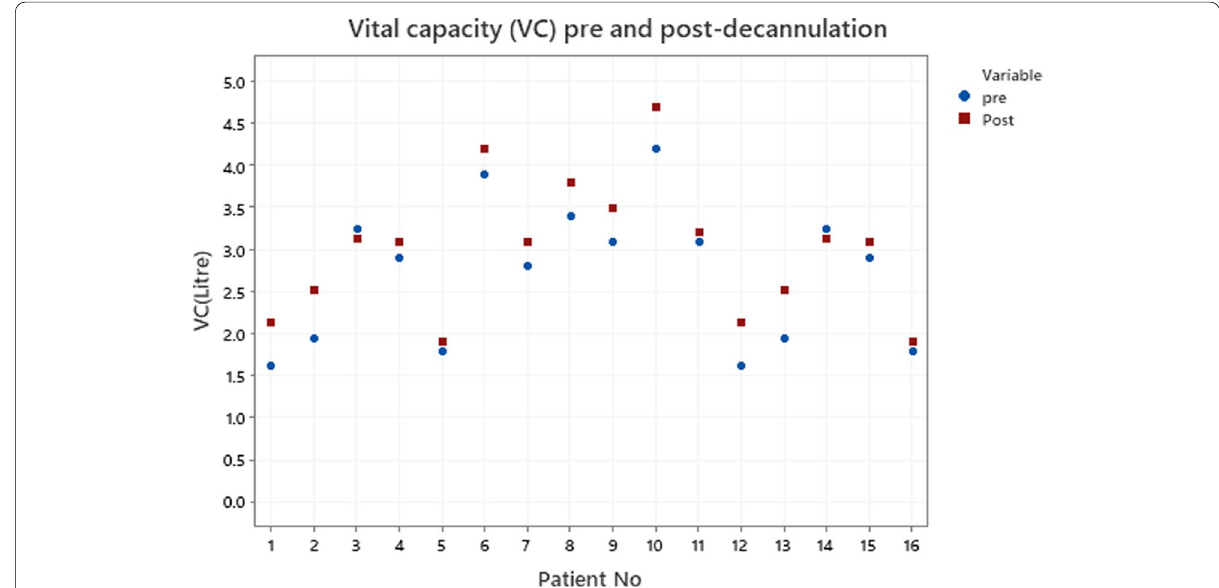
Fig. 3 Plot distribution of vital capacity in all studied subjects before and after decannulation